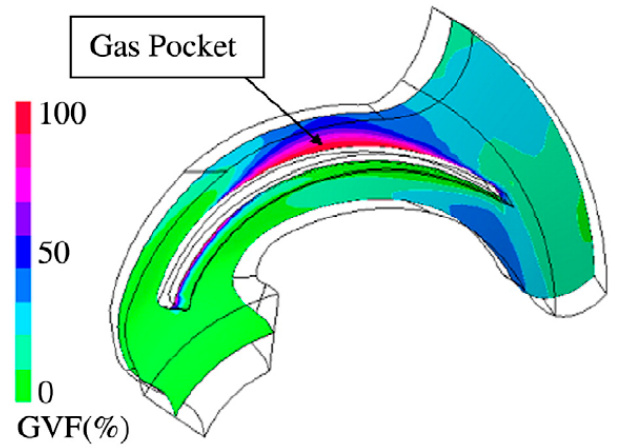
Figure 13. Typical multiphase CFD simulation results of gas/liquid flow in ESPs [108].